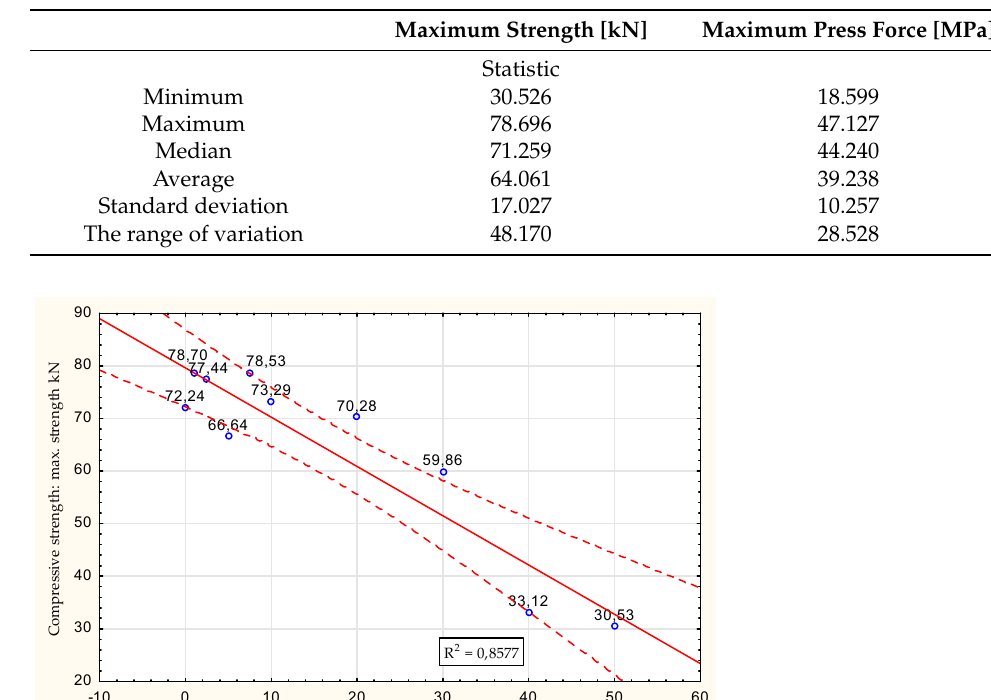
Table 12. Compressive strength tests for basalt dust A for all samples for water − mix ratio = 0.5.